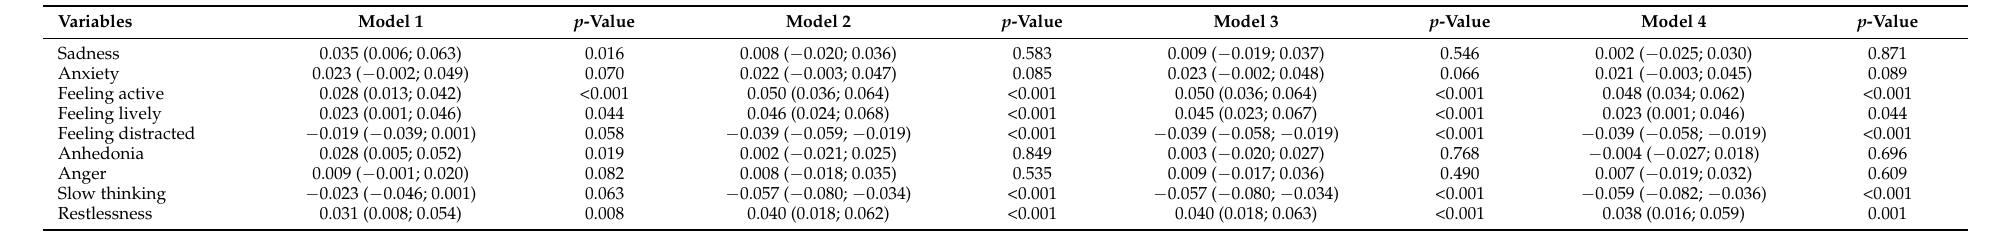
Table 3. Within-day, time-lagged associations of psychological states at time T − 1 predicting EMA hunger intensity at time T, CoLaus|PsyCoLaus study, Lausanne, Switzerland,